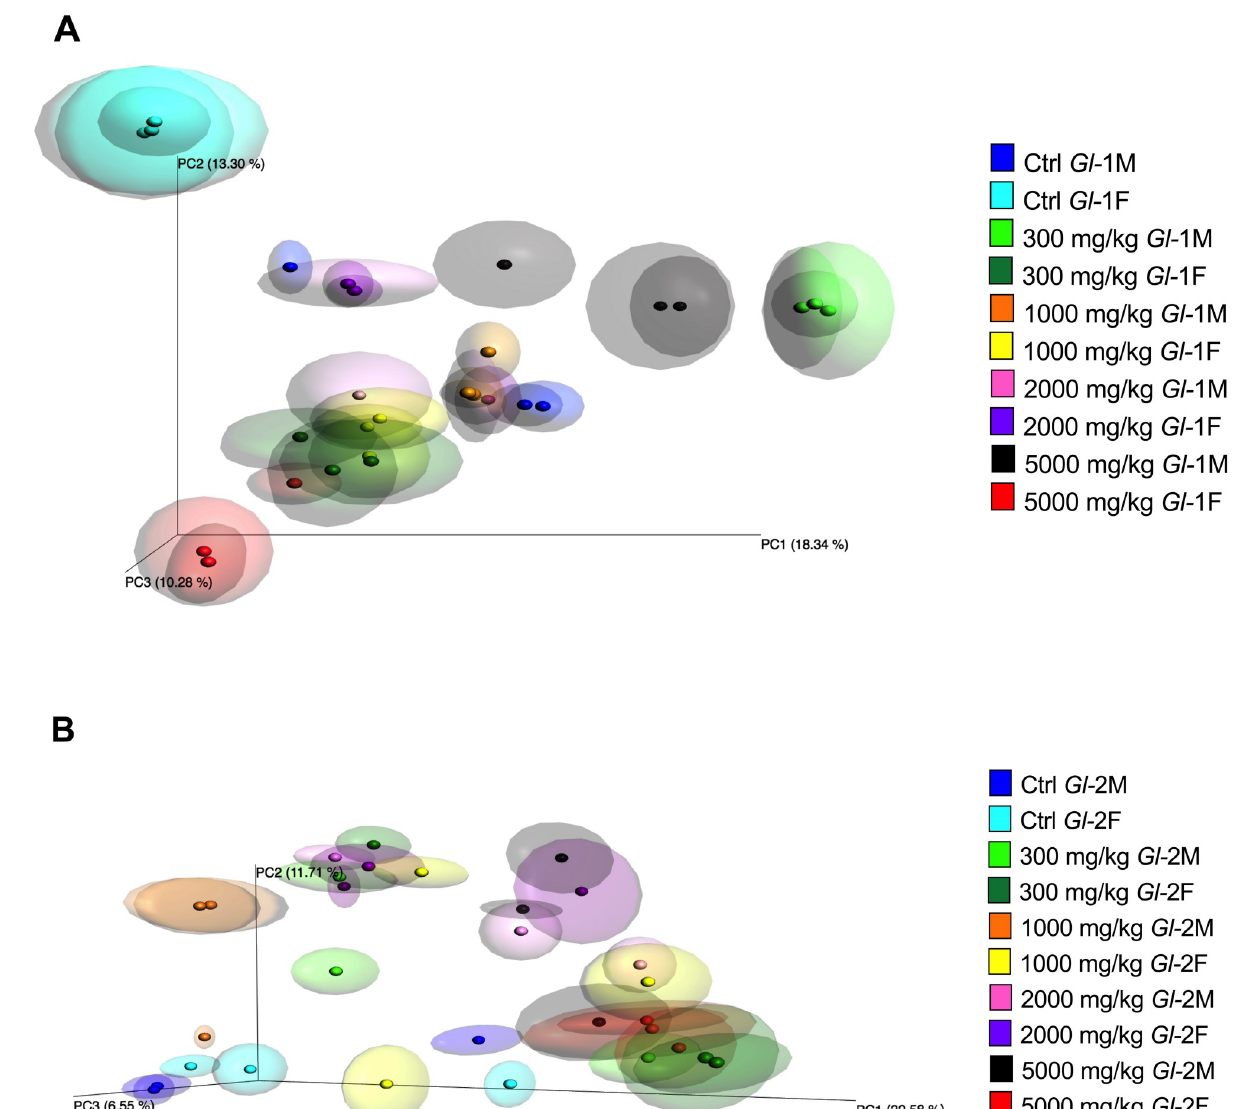
Fig 14. Principal coordinates analysis of beta diversity in the gut microbiota among male (M) or female (F) Wistar rats fed with the control diet (Ctrl) and different doses of standardized Gl -1 or Gl -2 extracts of Ganoderma lucidum for 14 experimental days. A: Administration of the Gl -1 extract. B: Administration of the Gl -2 extract. The dose administered per experimental group is described in the materials and methods section.